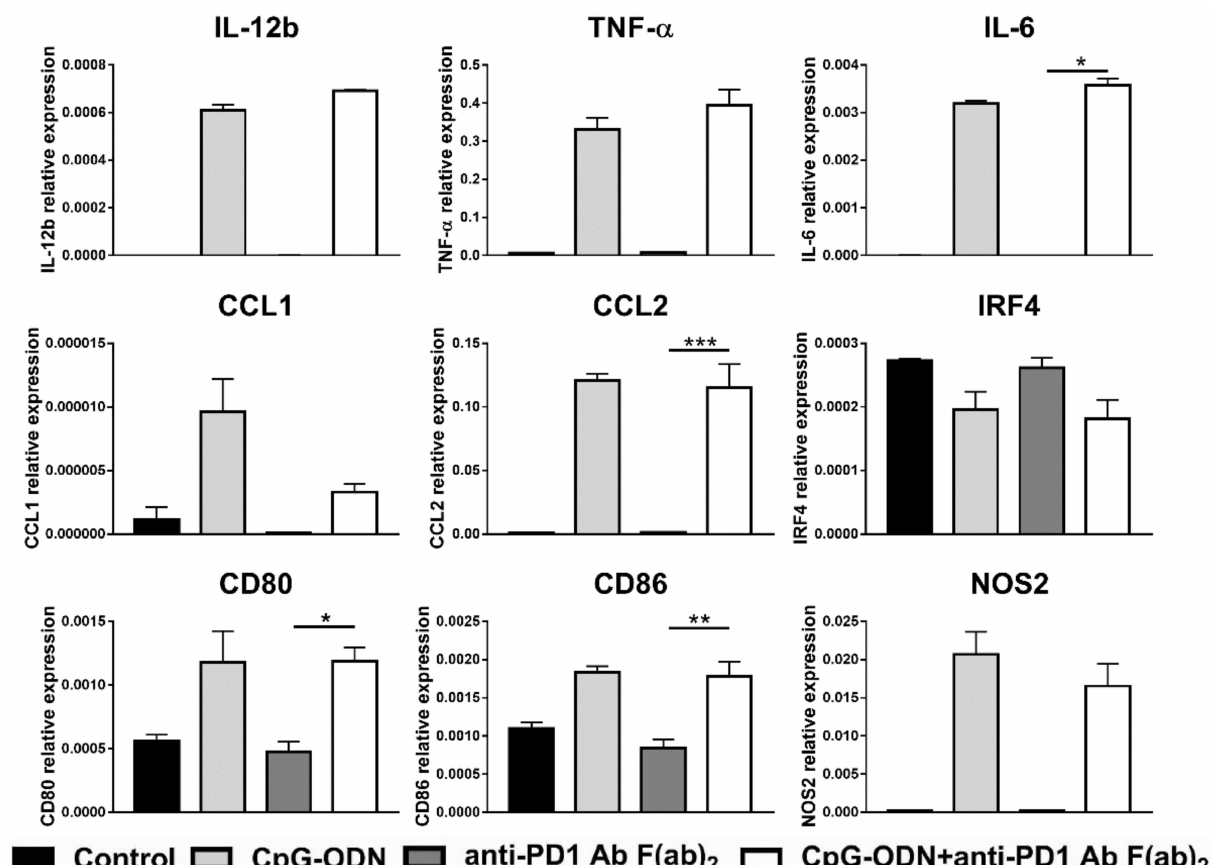
Figure 5. Effect of the combination of CpG-ODNs and anti-mouse PD-1 antibody F(ab) 2 on RAW264.7 macrophages in vitro. RAW264.7 macrophages were seeded in 12-well plates and then stimulated with 1 µ M CpG-ODN and 10 µ g/mL anti-mouse PD-1 antibody F(ab) 2 alone or in combination for 6 h. Controls were left untreated. At the end of treatment, mRNA was extracted, and real-time PCR was performed. The data were normalized to the expression of β 2m as a housekeeping reference gene and analyzed by the comparative 2 − ∆ Ct method. The data are presented as the mean ± SEM and were analyzed by one-way ANOVA followed by Tukey’s multiple comparison test with a single pooled variance or by the Kruskal–Wallis test followed by Dunn’s multiple comparison test for nonparametric data. * p < 0.05, ** p < 0.01, and *** p < 0.001. CpG-ODNs: CpG oligodeoxynucleotides; anti-PD-1 Ab: anti-PD-1